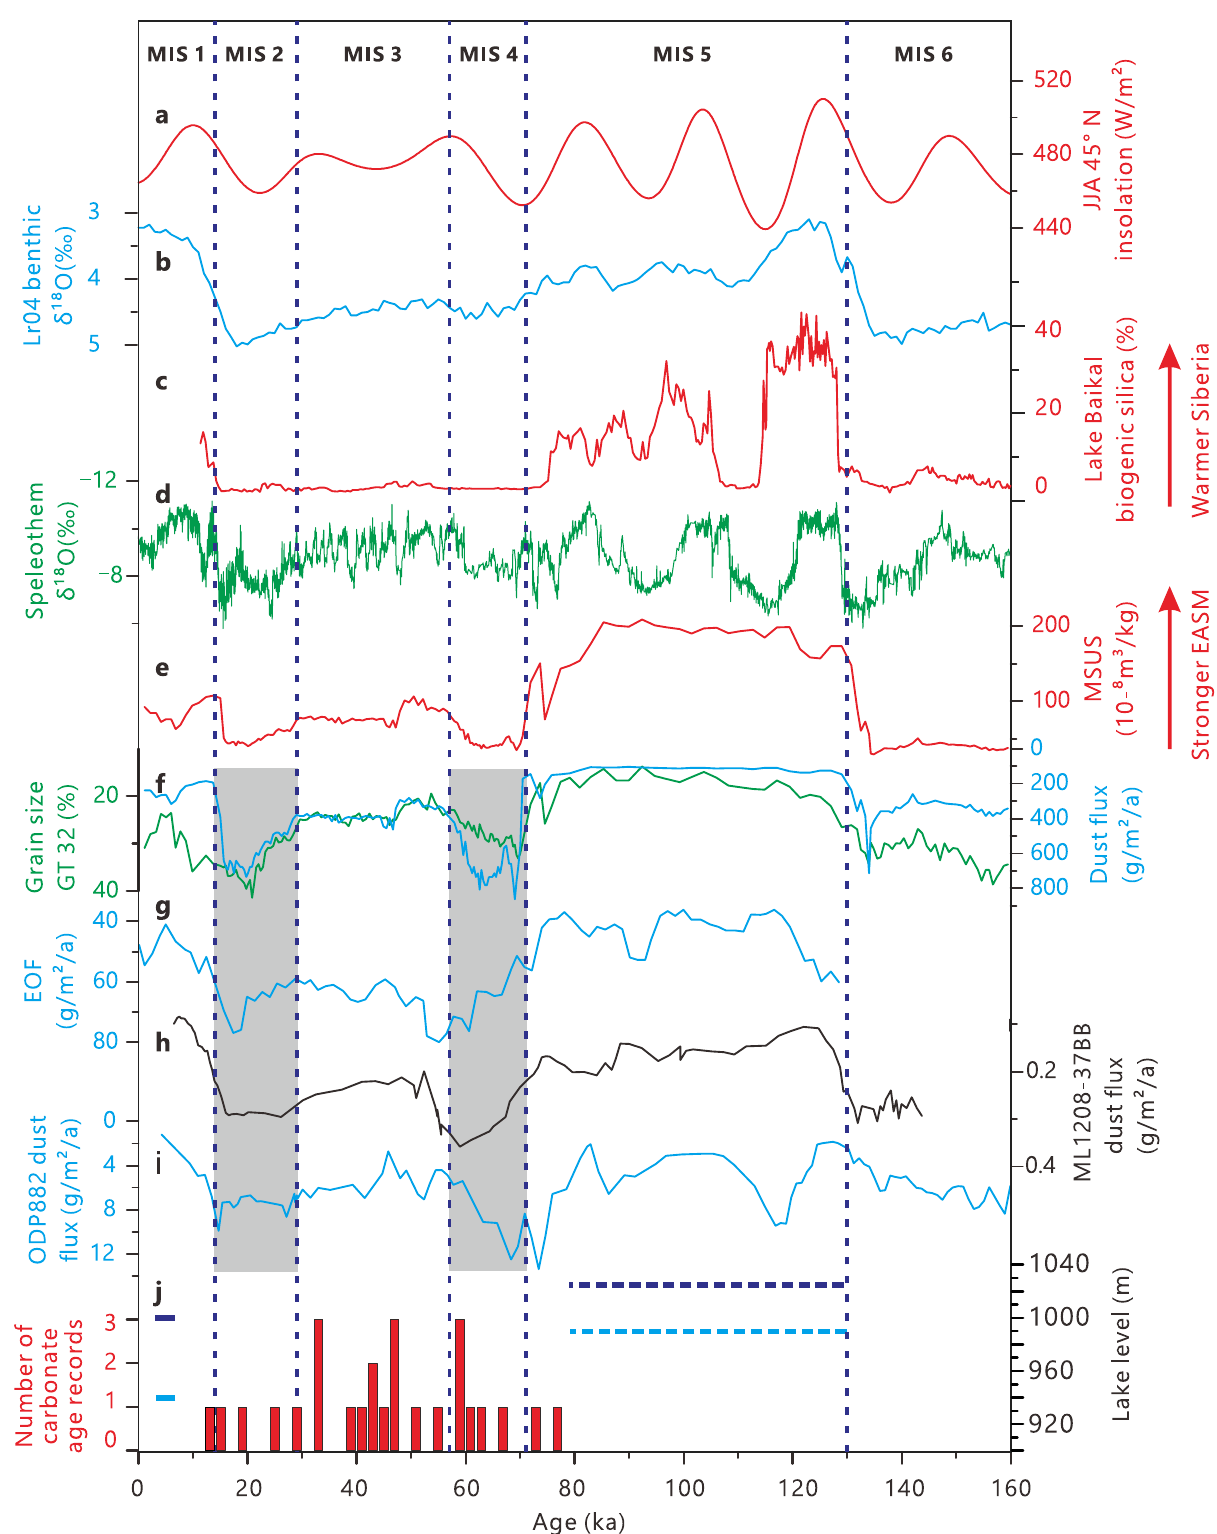
Fig.7|Recordsfromthisstudycomparedagainstotherproxyandforcingtime series. a Summer (June to August) insolation at 45 °N 99 , b δ 18 O record of LR04 benthic stack 100 , ( c) Lake Baikal biogenic silica record 101 , d Composite stalagmite oxygenisotopedata fromsouth China 102 . e,f Magneticsusceptibility( e ),grain size data( f )shownbygreaterthan32 μ mfraction(GT32,green)anddust fl ux(blue)of